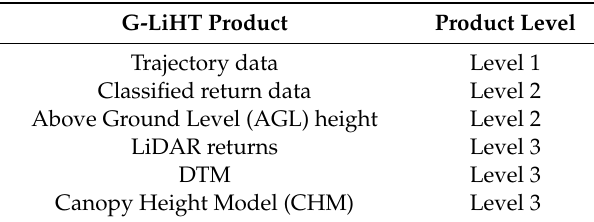
Table 3. The Goddard’s LiDAR, Hyperspectral and Thermal imager (G-LiHT) product levels